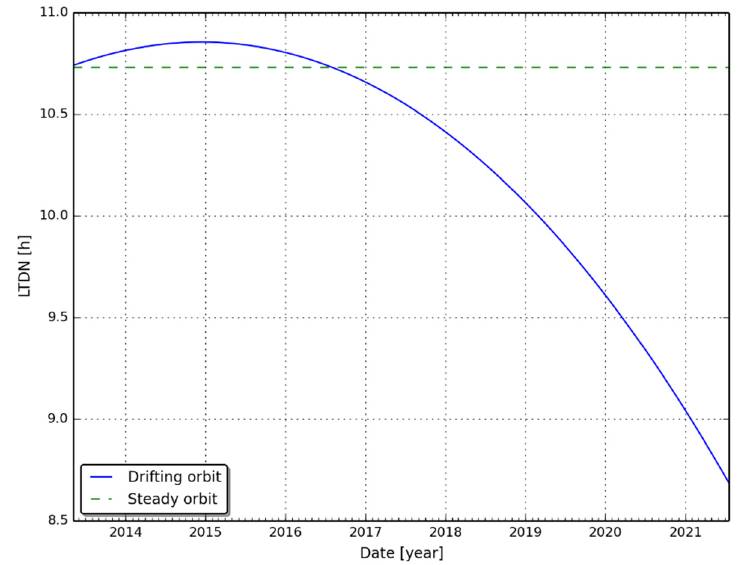
Figure 2. The figure shows the predicted LTDN variation (h) of Proba-V orbit using flight model simulations. The drifting orbit (blue) is plotted together with a steady sun-synchronous orbit (dotted green) having a stable LTDN, fixed to the value reached after launch (10:45 a.m.).